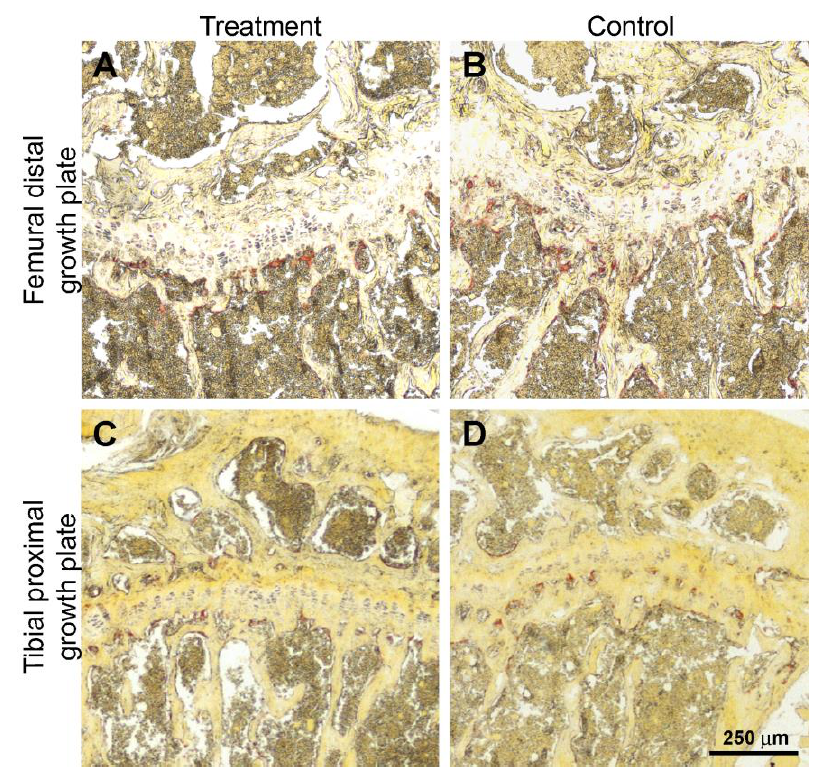
Figure 6. Representative histological sections of the TRAP reaction (osteoclasts are stained in red) in the osteo-chondral interface along the growth cartilage and diaphyseal bone of femoral distal metaphysis ( A , B ) and tibial proximal metaphysis ( C , D ) of treatment and control groups. T he number of osteoclasts (NOc/BS) doesn’t change between treatment and control groups, both in the tibia and the femur, as reported in Table 4. Table 4. Number of osteoclasts (NOc/BS) measured in interface along the growth cartilage and diaphyseal bone of femoral distal metaphysis and tibial proximal metaphysis sections. All values are expressed as mean ± S.D. (n = 7 for each group).